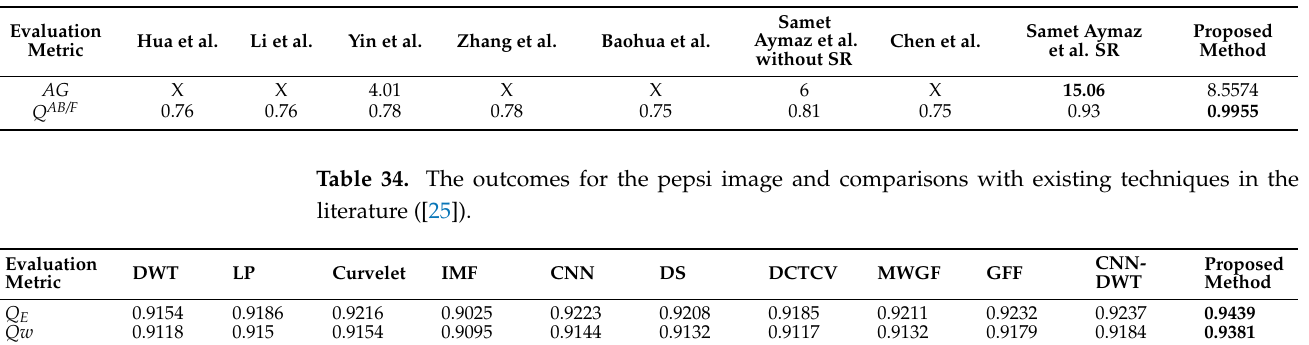
Table 35. The outcomes for the pepsi image and comparisons with existing techniques in the literature ([27]).